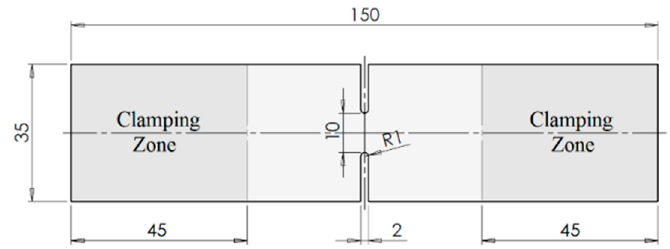
Figure 3. Plane-strain tension specimen geometry and dimensions (mm) [33].